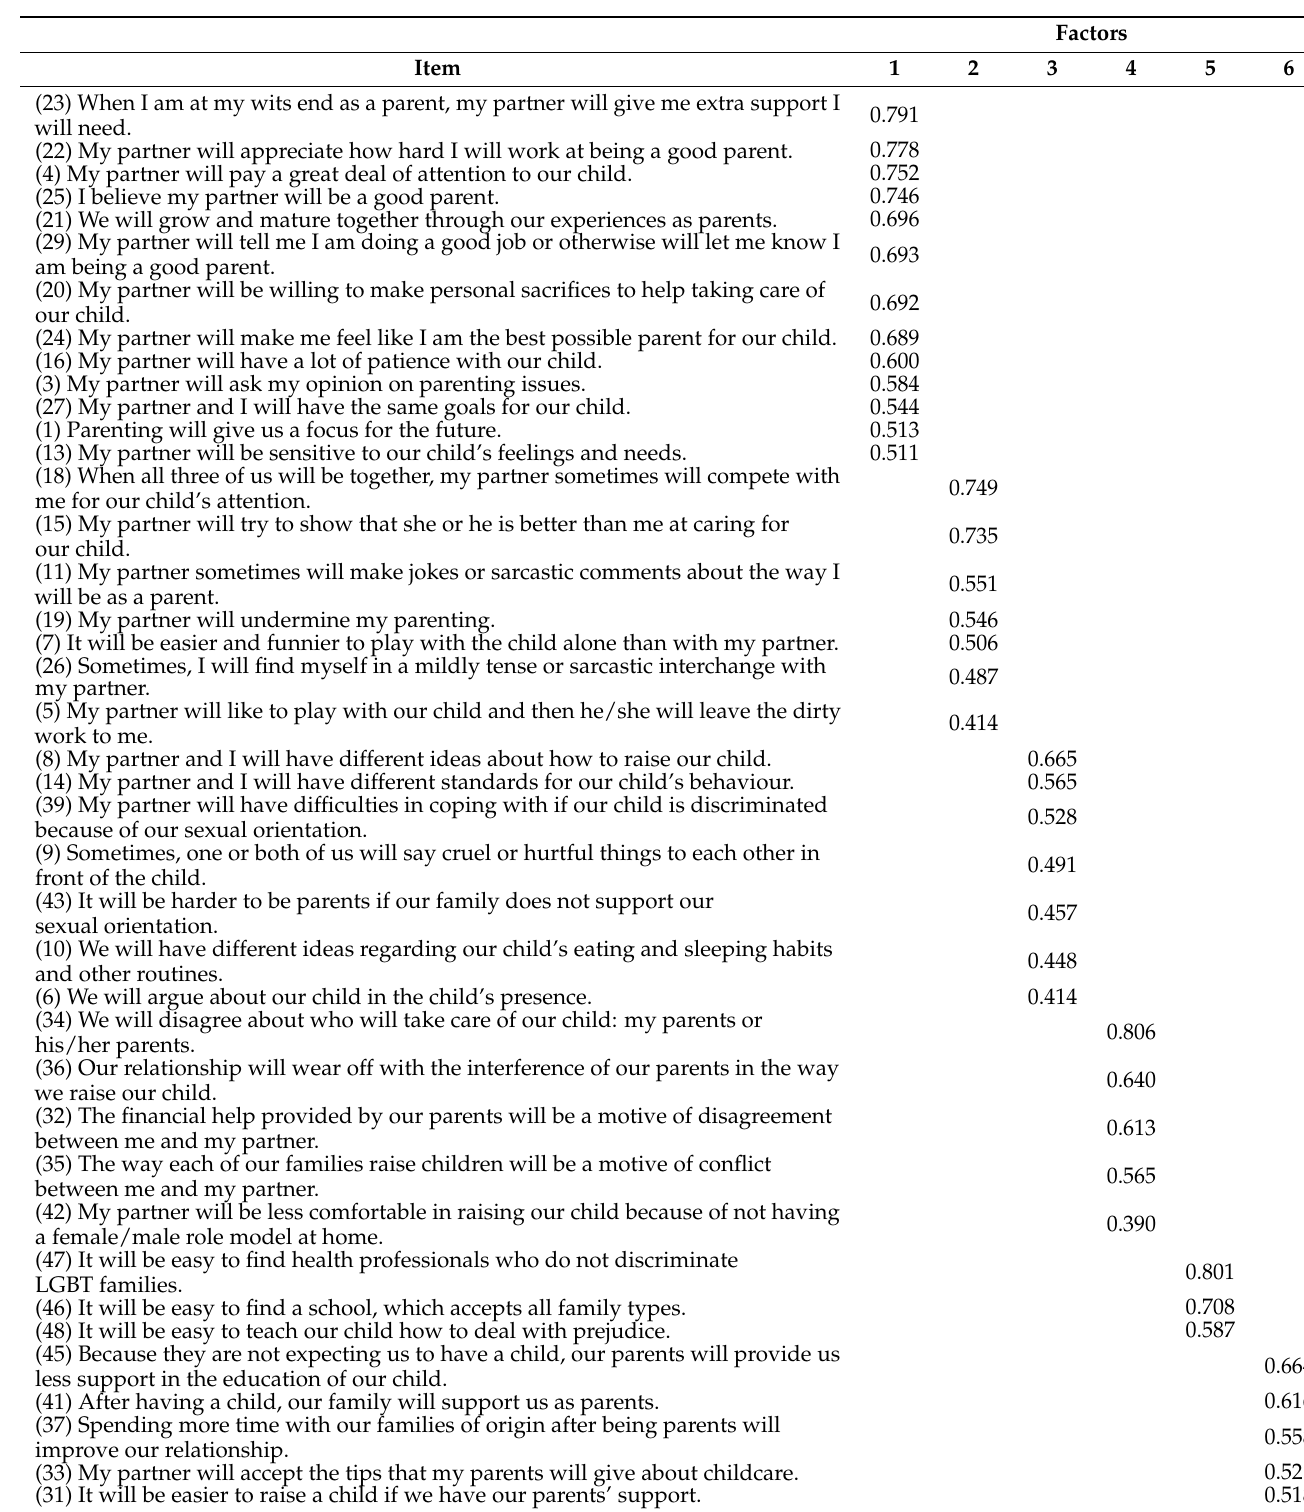
Table 4. Final Exploratory Factor Analysis (EFA) of Prospective Coparenting Relationship Scale (PCRS) with Varimax Rotation and Kaiser Normalization among Sexual Minority